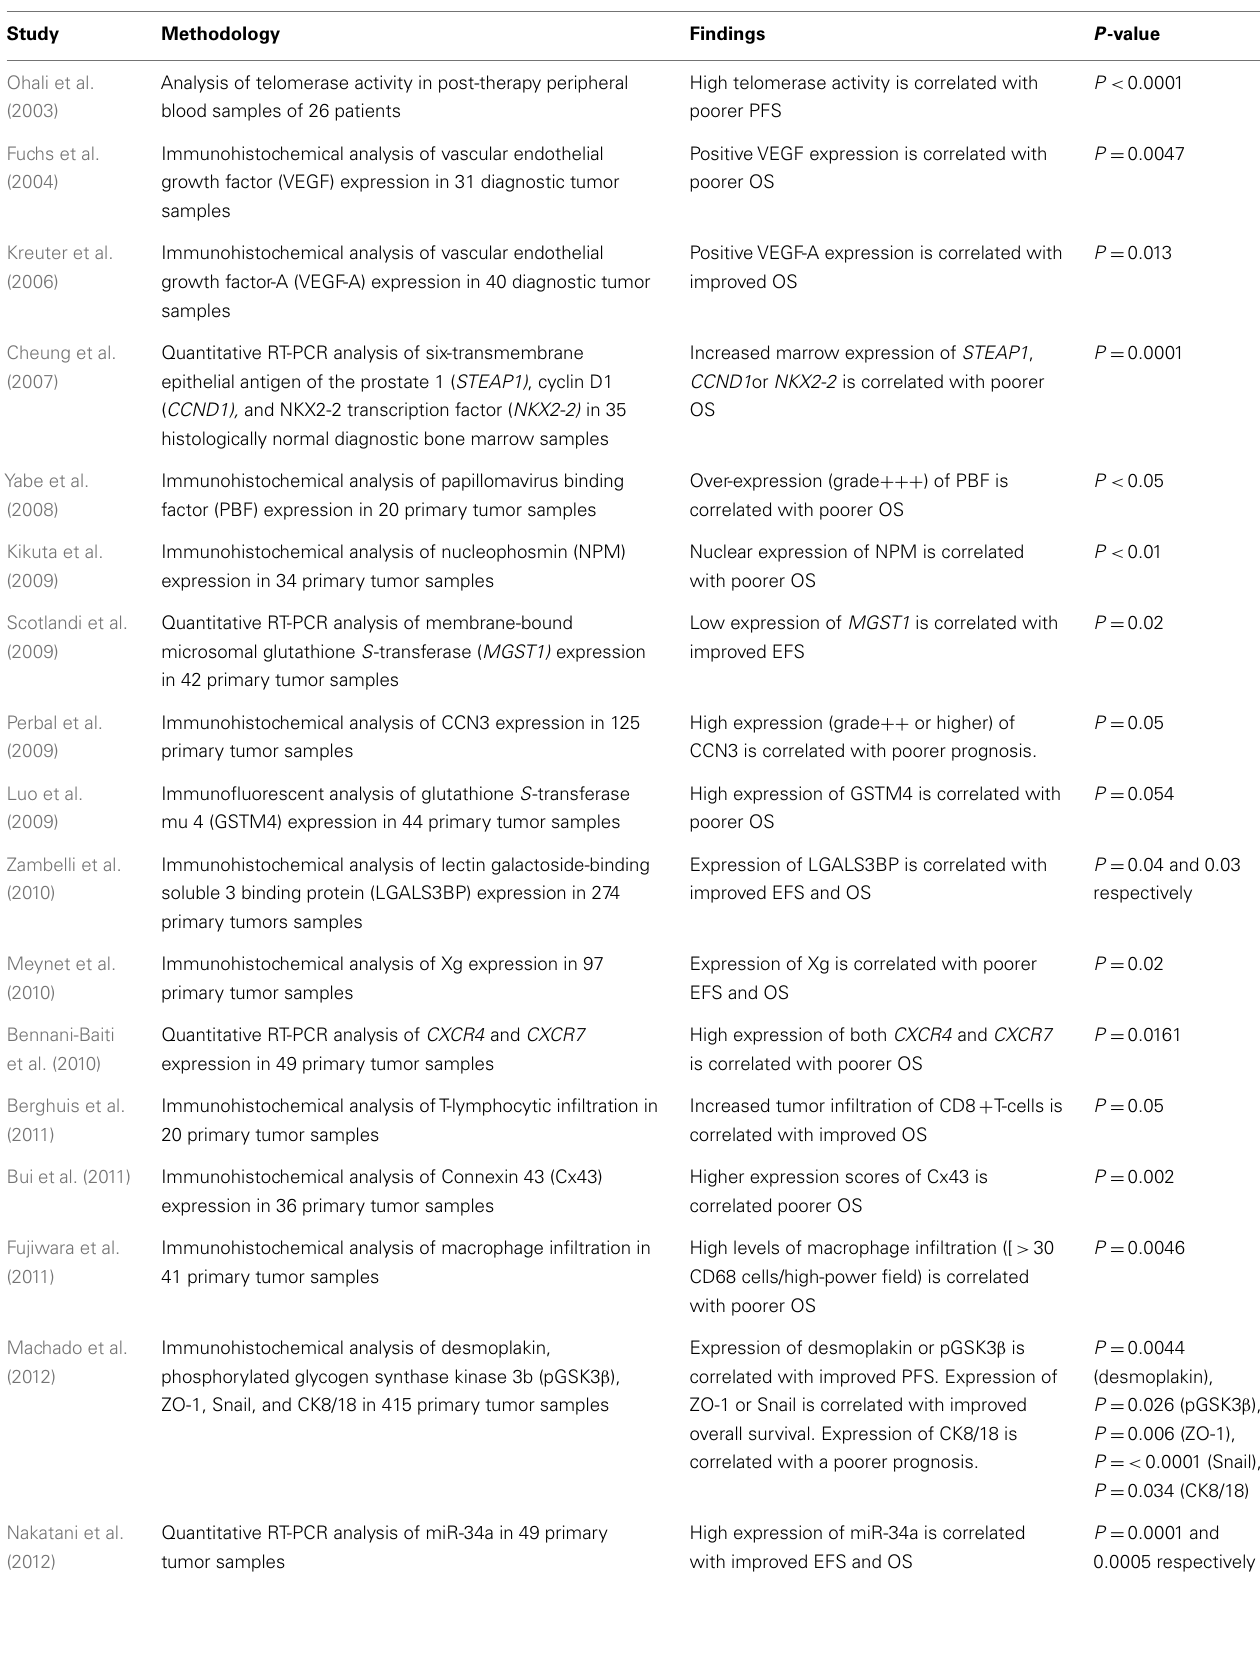
Table 4 | Recent studies examining potential Ewing sarcoma